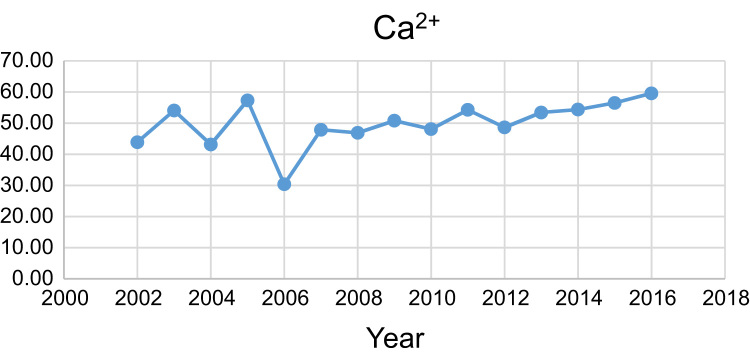
Ca2+ trend for groundwater in Abhar city.